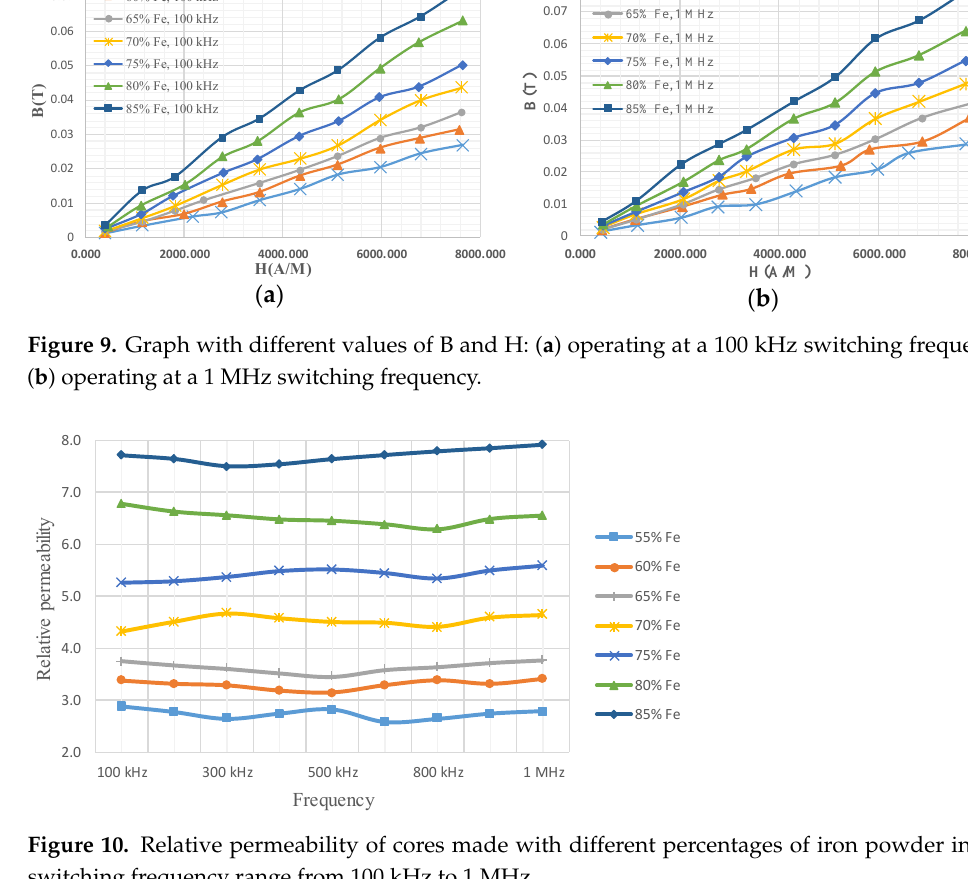
Figure 9. Graph with different values of B and H: ( a ) operating at a 100 kHz switching frequency, ( b ) operating at a 1 MHz switching frequency.